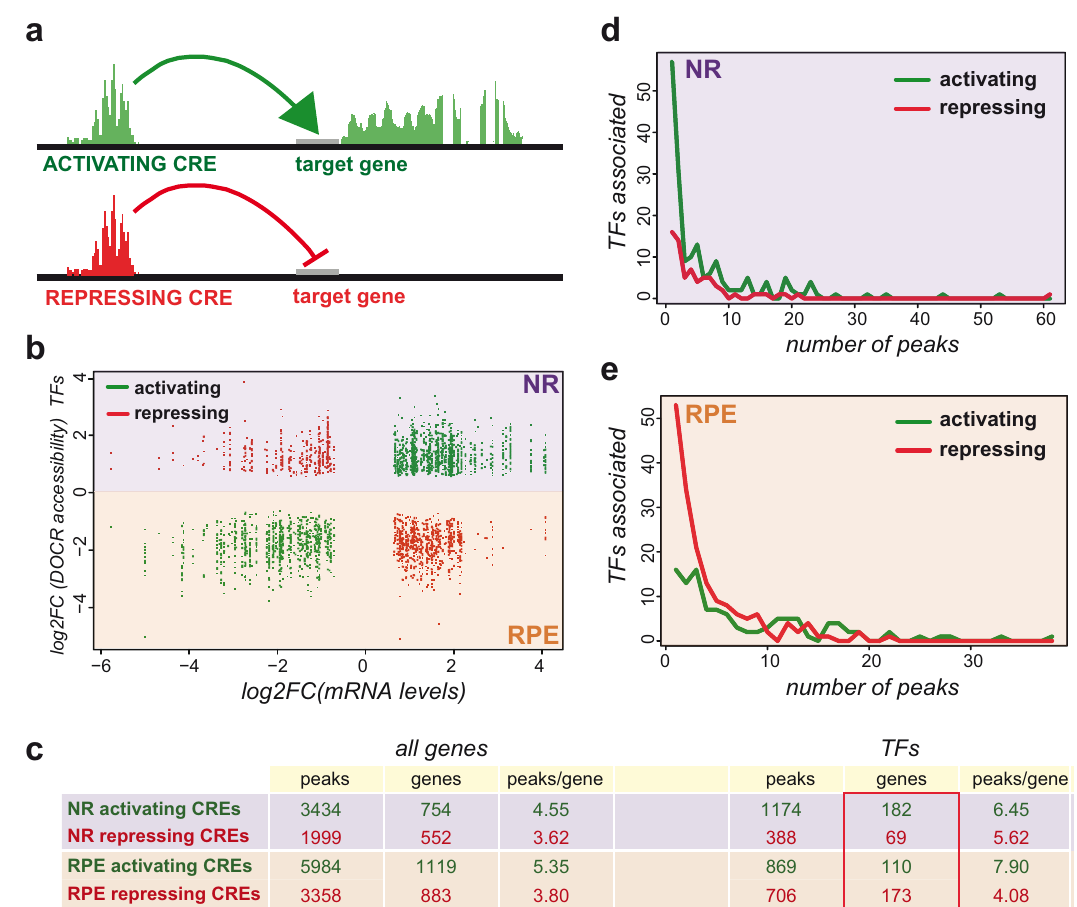
Fig. 2 CRE con fi guration in the NR and RPE domains. a Schematic representation of the functional relationship between DOCRs, either activating (green) or repressing (red), and their associated DEGs. b The graph illustrates the correlation between the levels of differentially expressed TFs (log2FC) and the accessibility of their associated DOCRs (log2). c The table summarizes the number of activating or repressing CREs associated with either all the DEGs or only with the differentially expressed TFs. d , e Histograms correlating the number of TFs associated with activating or repressing CREs to the number of peaks per gene, for both the NR ( d ) and RPE ( e )